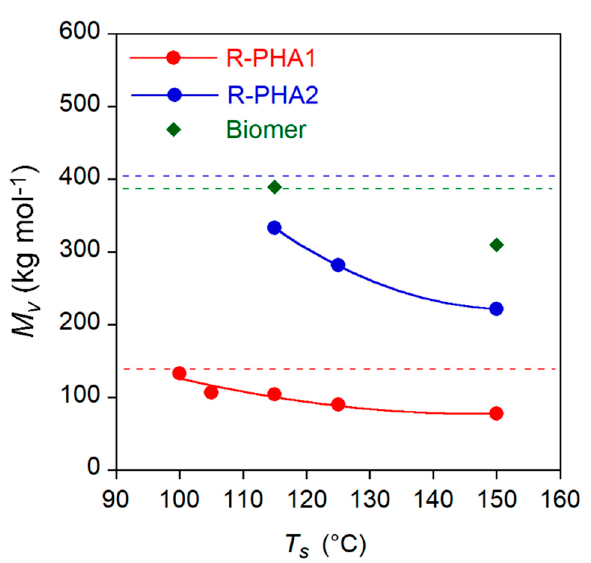
Figure 3. PHA1, R-PHA2 and Biomer viscosimetry average molecular weight ( M v ) variation as a function of the dissolution temperature in EA. Dotted lines indicate the M v values of R-PHAs and of pristine Biomer. Solids curves are a guide for the eyes.